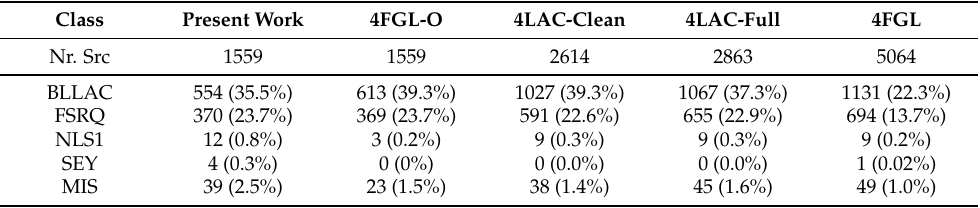
Table 1. Comparison with statistics of 4LAC Clean samples (extragalactic sources with | b | > 10 ◦ and FLAGS = 0 ), 4LAC full sample (all sky), and 4FGL (data from tables in [5,6]). In the cases of 4LAC and 4FGL, the MIS class corresponds to the sum of the classes RDG/rdg, CSS/css, and SSRQ/ssrq. 4FGL-O refers to the original classification of the same dataset of the